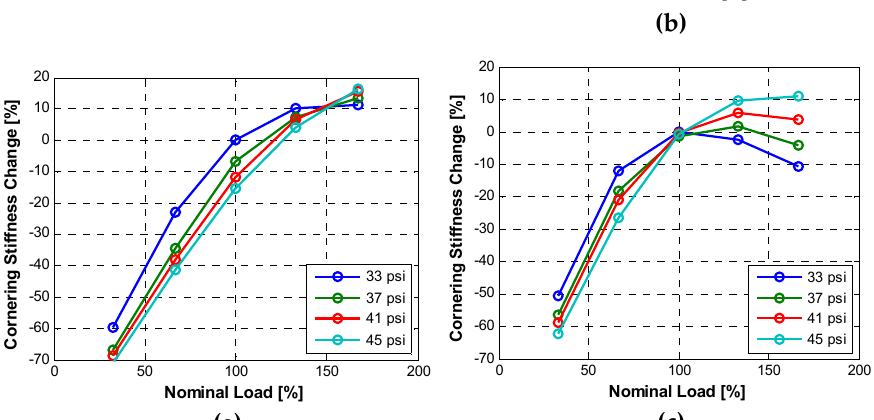
Figure 9. Influence of inflation pressure on the tire cornering stiffness.